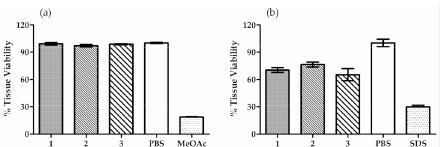
Figure 2. Tissue viability results obtained in ( a ) SkinEthic™—Eye irritation test, and ( b ) EpiSkin™— Skin irritation test. PBS was used as a negative control for both assays, while methyl acetate (MeOAc) and SDS were used as positive controls for SkinEthic™ and EpiSkin™, respectively. Results are mean ± SD, n = 2 ( a ), n = 3 ( b ).